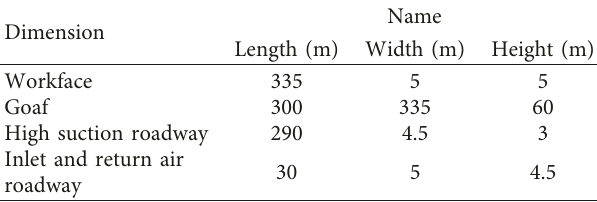
Table 1: Dimension of the 9101 workface physical